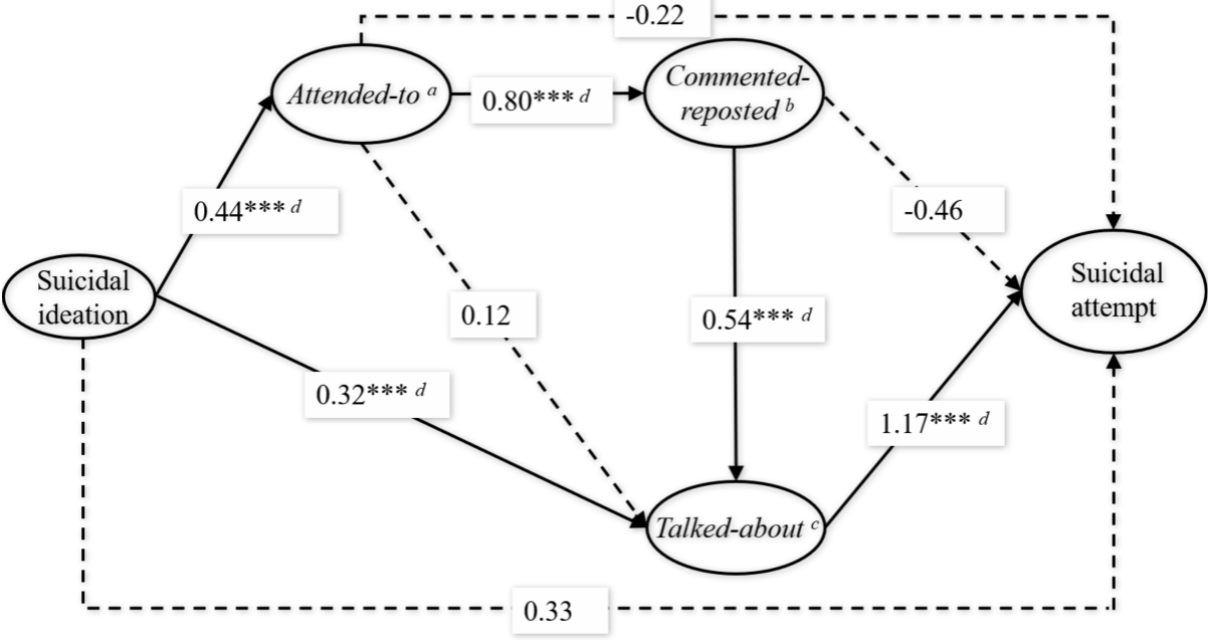
Figure 2. The mediating effect of social media use behaviors in the association between suicidal ideation and suicide attempt. a) Attended to suicide